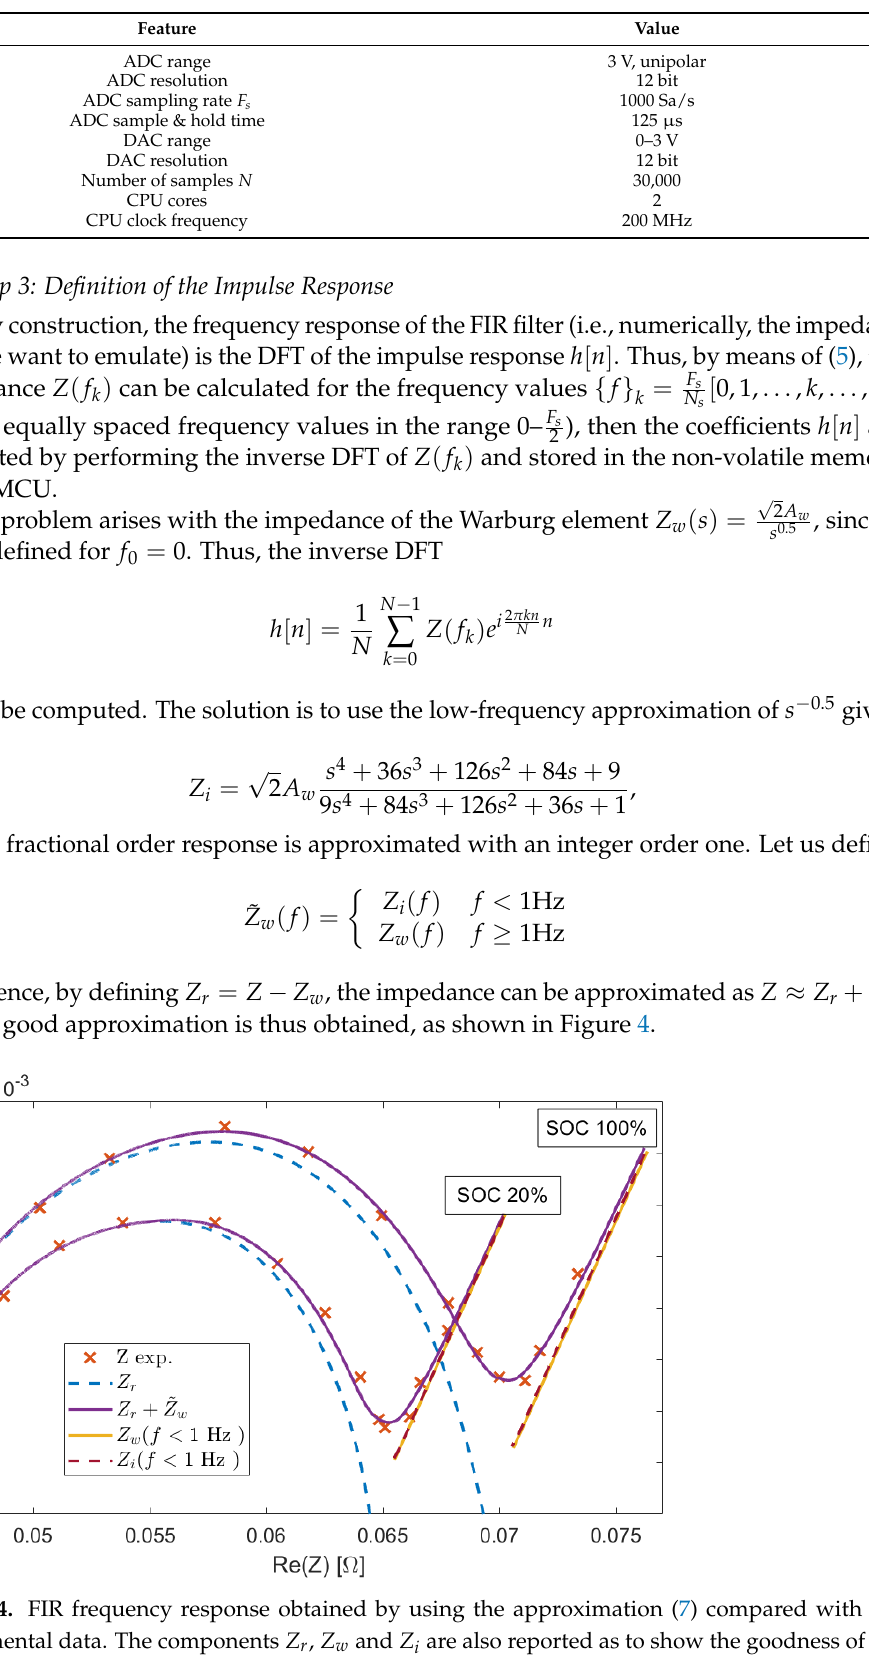
Table 1. Technical features of the impedance emulator prototype.